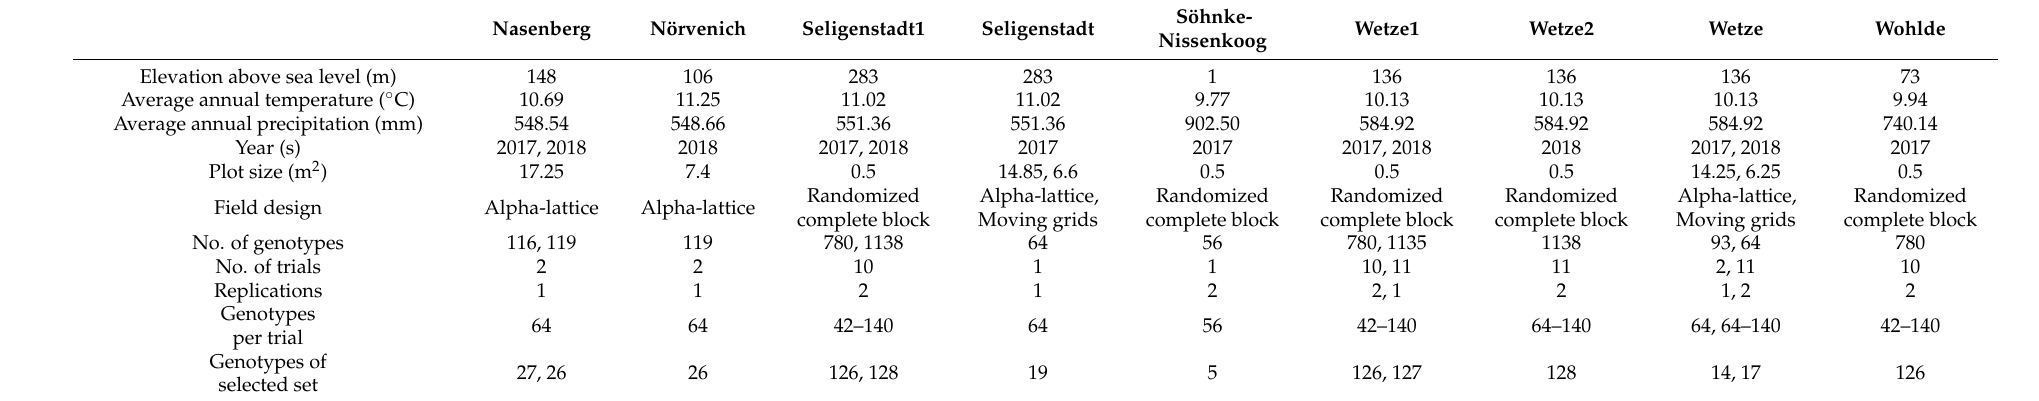
Table 1. Characterization of field environments, in which leaf rust resistance was